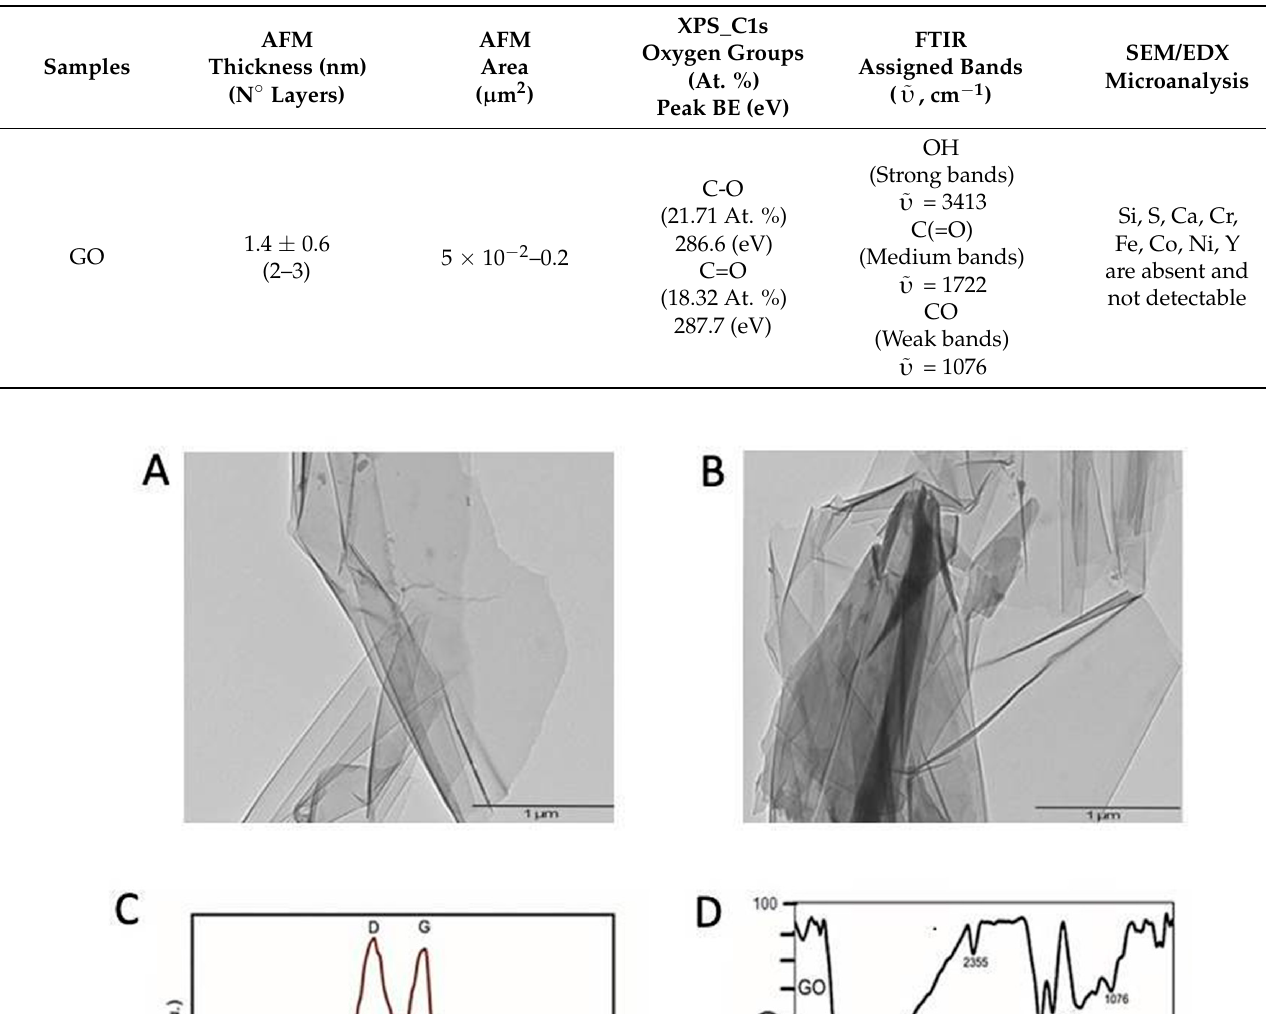
Table 1. Characterization of functionalized graphene oxide, GO.